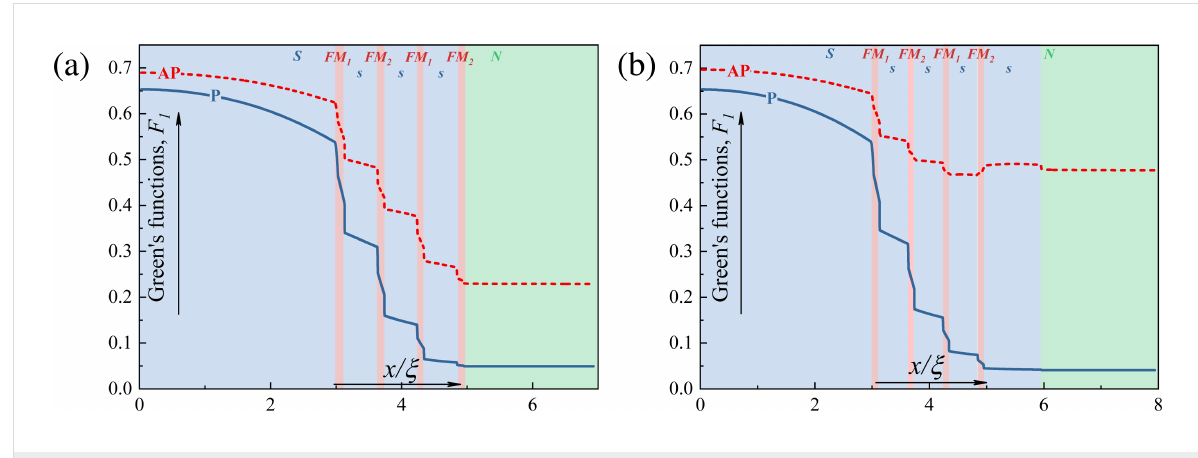
Figure 6: Spatial distribution of the pair amplitude F in the hybrid structures (a) S–FM 1 –s–FM 2 –s–FM 1 –s–FM 2 –N without additional s 1 layer and (b) S–FM 1 –s–FM 2 –s–FM 1 –s–FM 2 –s 1 –N with an additional superconducting layer for parallel (blue solid line) and antiparallel (red dashed line) mutual orientations of magnetization between FM 1 and FM 2